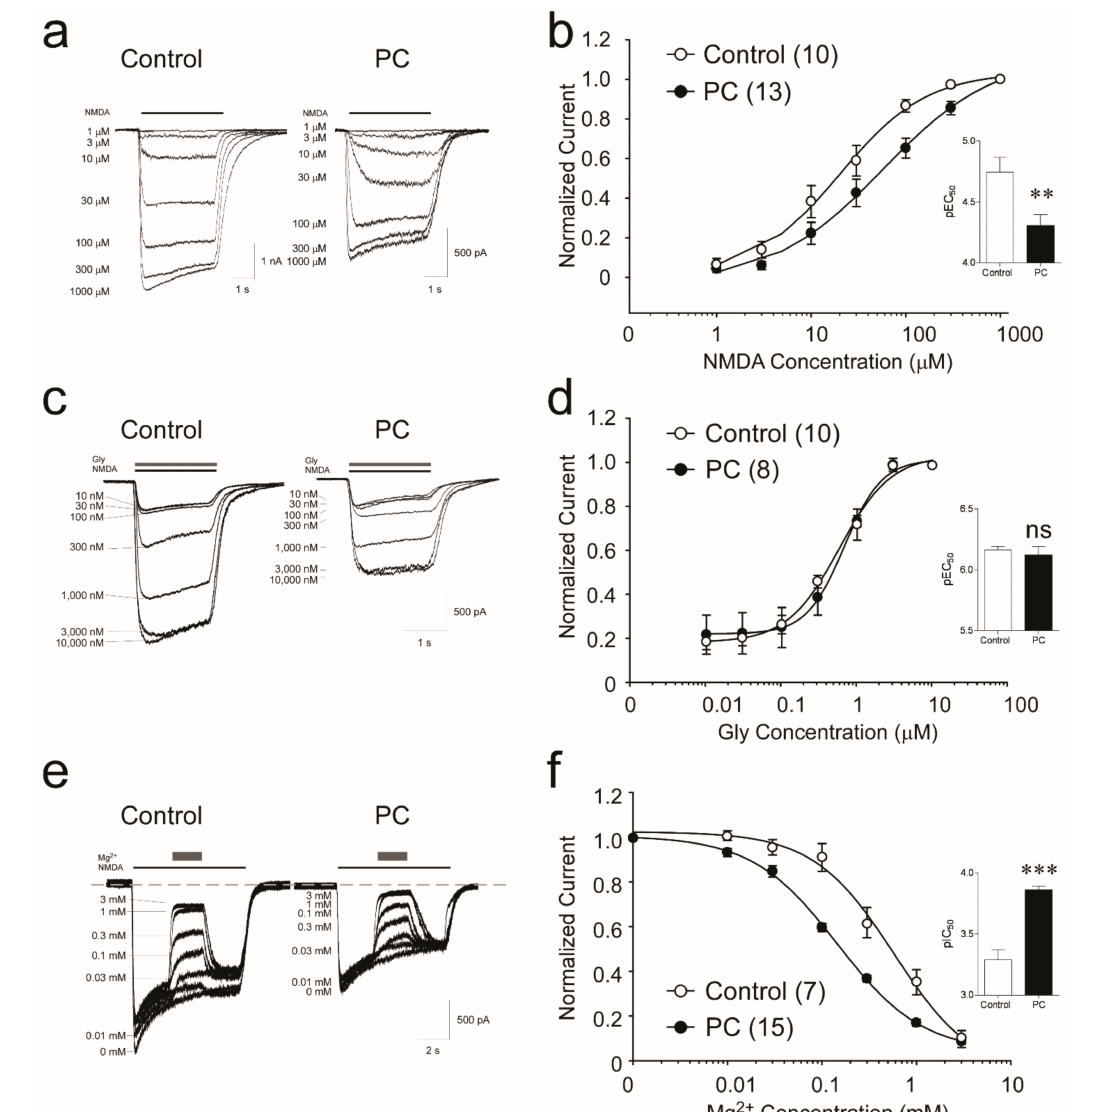
Figure 2. Ischemia-preconditioned neurons show decreased sensitivity to NMDA, unchanged re- sponse to Gly, and increased sensitivity to Mg 2+ block. ( a ) Whole-cell recording was performed at − 60 mV with 1 µ M TTX and 3 µ M Gly present. NMDA currents were evoked with 1–1000 µ M NMDA (black line) in control and PC neurons. ( b ) The concentration–response relationship of NMDA-evoked currents was obtained by fitting correspondent I ss with Hill equation. Inserts shown are mean ± sem of pEC 50 values generated from individual fittings from 10 control and 13 PC neurons (** denotes p < 0.01, unpaired Student’s 2-tail t -test). ( c ) Gly sensitivity determined by applying 10–10,000 nM of Gly (grey line) with 100 µ M NMDA (black line) on control and PC-treated neurons. Cells were bathed in ECF containing 1 µ M TTX, but no Gly. ( d ) The concentration–response rela- tionship of Gly-dependent currents in control and PC neurons. Insert: pEC 50 values generated from individual fittings to Iss from 10 control and 8 PC neurons. No statistical significance is found (data are mean ± sem; p > 0.05, unpaired Student’s 2-tail t -test). ( e ) The Mg 2+ blockage to NMDA currents was assessed by applying 0.01 − 3 mM of Mg 2+ (grey bar) in the middle of NMDA application (black line) in control and PC neurons. ( f ) The concentration–response relationship was calculated by fitting the Iss values with Hill equation. Insert: pIC 50 calculated from individual fittings of control and PC-treated neurons (*** denotes p < 0.001, unpaired Student’s 2-tail t